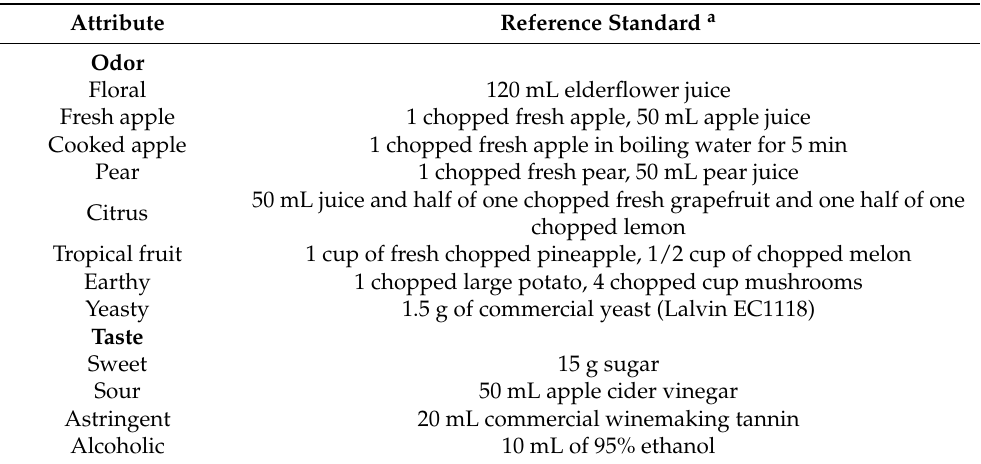
Table 2. Sensory attributes tested as chosen by sensory panel in initial sensory assessment and corresponding reference standards